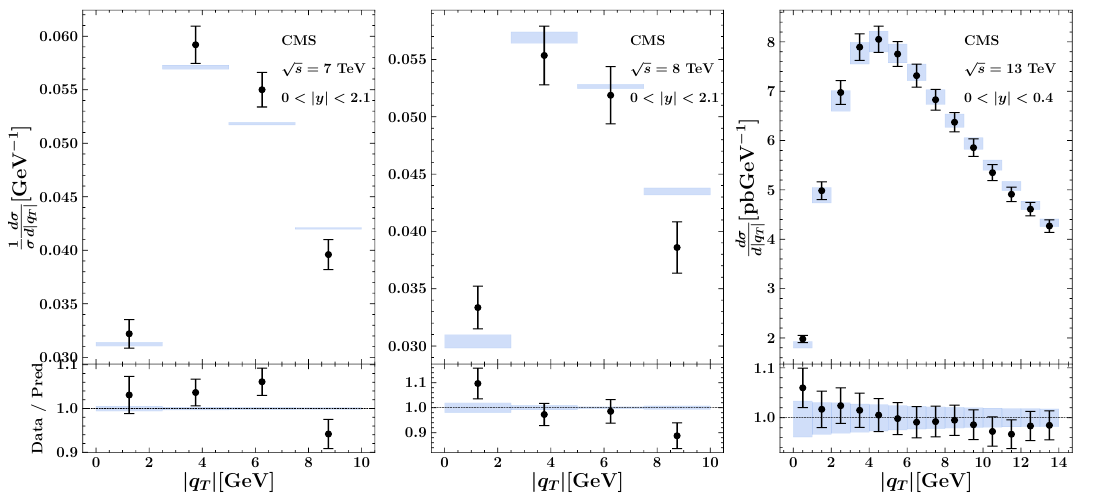
Figure 10 . Same as in previous figure but for Z boson production in pp collisions measured by the CMS Collaboration. From left to right: increasing √ s = 7, 8, 13 TeV, respectively. For √ s = 7, 8 TeV, the results are normalized to the fiducial cross section.